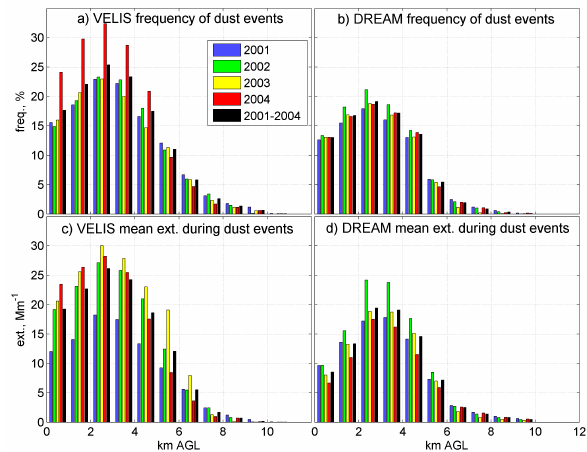
Fig. 2. Vertical distribution of Saharan dust layers properties as ob- Figure 2 . Vertical distribution of Saharan dust layers properties as observed by VELIS (left 690 served by VELIS (left column) and forecast by BSC-DREAM8b column) and forecast by BSC-DREAM8b (right column), respectively: frequency of 691 (right column), respectively: frequency of Saharan dust occurrences Saharan dust occurrences at least in one altitude bin (plots a and b) and average dust 692 at least in one altitude bin (a, b) and average dust extinction coeffi- extinction coefficient (km -1 at 532 nm) per year (plots c and d). 693 cient (km − 1 at 532nm) per year (c, d) .